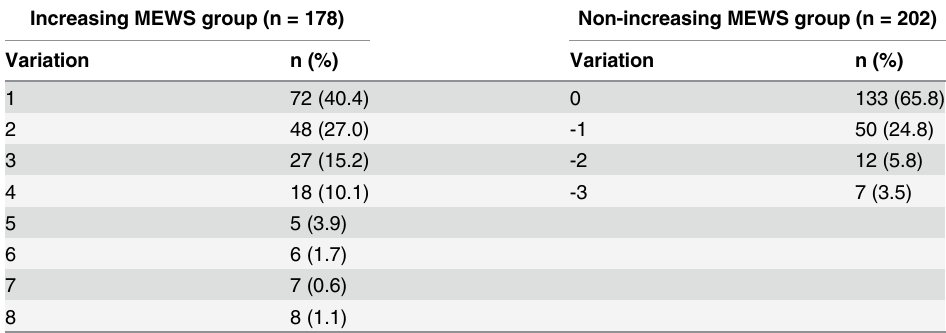
Table 4. Variation of the Modified Early Warning Score (MEWS) from MEWS 24 to MEWS 8 .